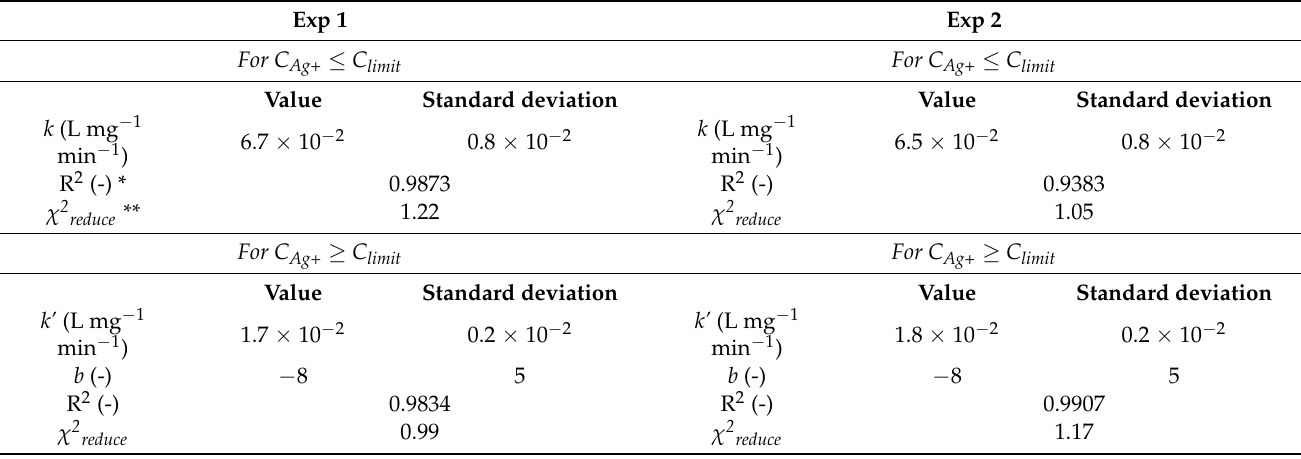
Table 4. Values obtained for the parameters of the Haas and Karra model from experiments (Exp 1 and Exp 2, respectively).